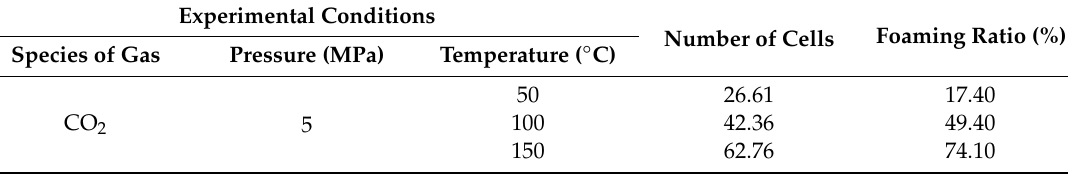
Figure 7. Experimental results for the correlation between the foaming ratio and fixing ratio ( a ) and recovery ratio ( b ) according to the foaming temperature. Table 8. Foaming properties of thermoplastic polyurethanes (TPU) according to foaming